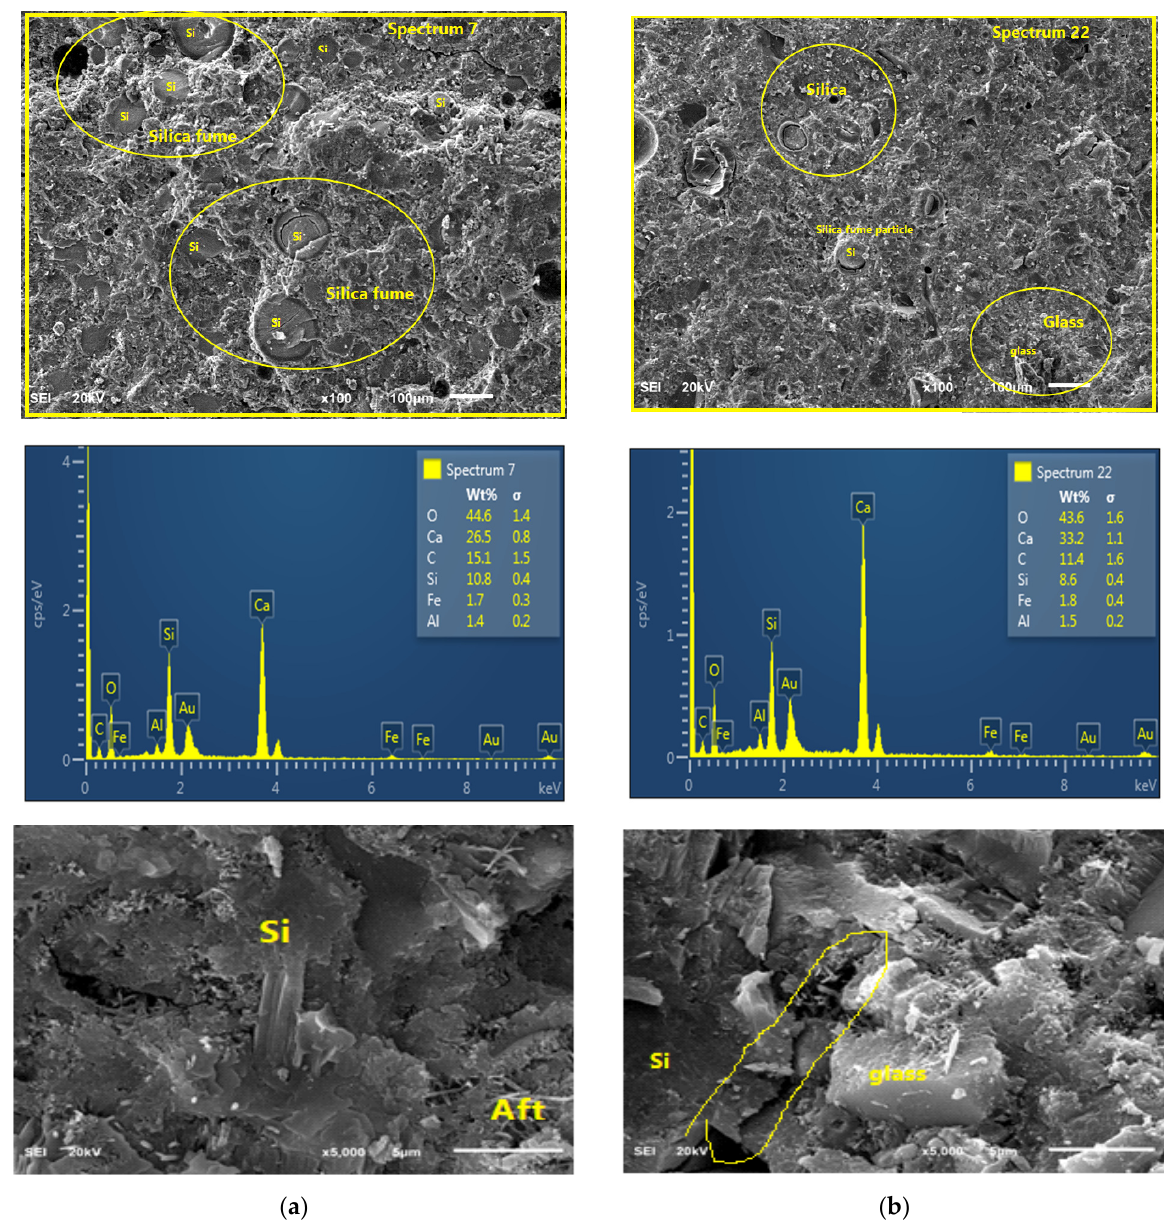
Figure 6. Morphology of silica fume (binary) blended paste ( a ) in comparison with the silica fume/glass (ternary) paste ( b ). ( a ) Silica-fume blended paste. ( b ) Silica-fume/glass-powder (ternary)